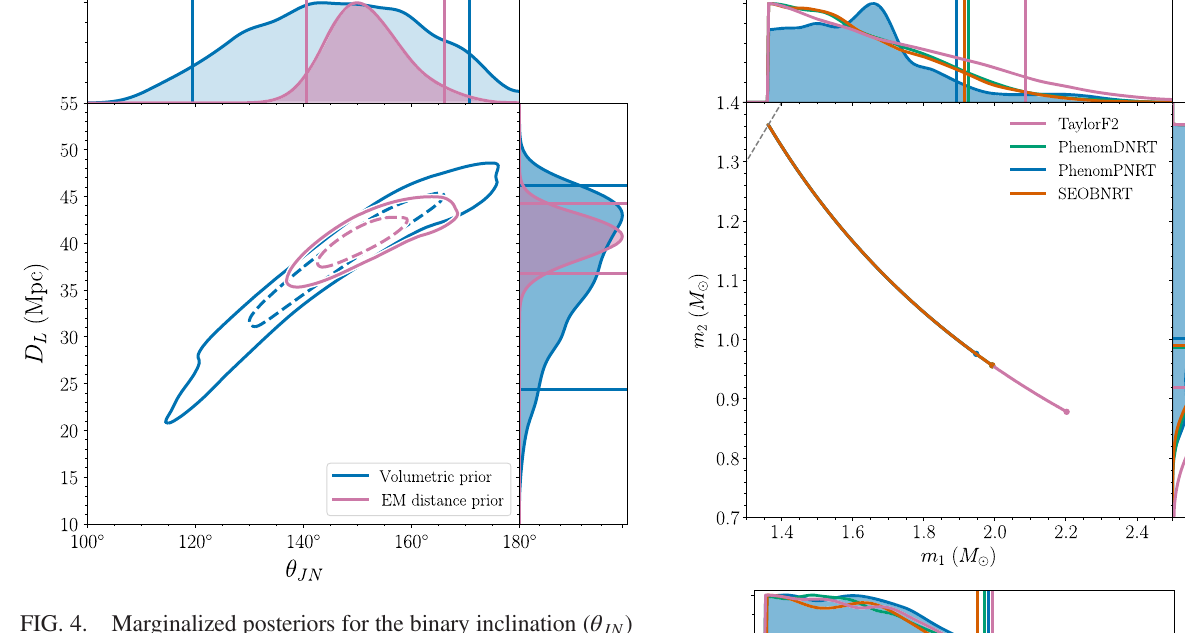
FIG. 4. Marginalized posteriors for the binary inclination ( θ JN ) and luminosity distance ( D L ) using a uniform-in-volume prior (blue) and EM-constrained luminosity distance prior (purple) [108]. The dashed and solid contours enclose the 50% and 90% credible regions, respectively. Both analyses use a low-spin prior and make use of the known location of SSS17a. The 1D marginal distributions have been renormalized to have equal maxima to facilitate comparison, and the vertical and horizontal lines mark 90% credible intervals.